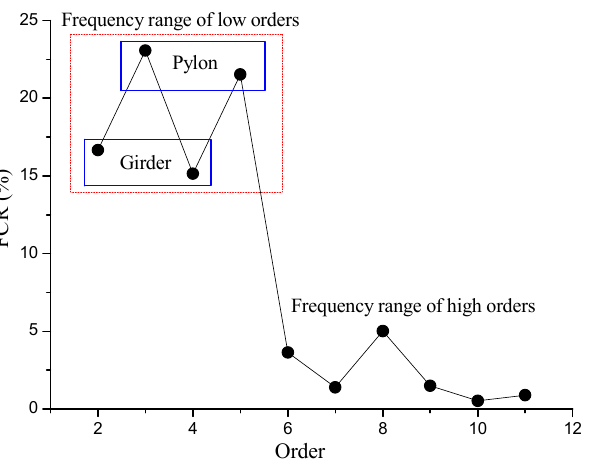
Figure 8. Values of FCR corresponding to different orders of the vibration mode.